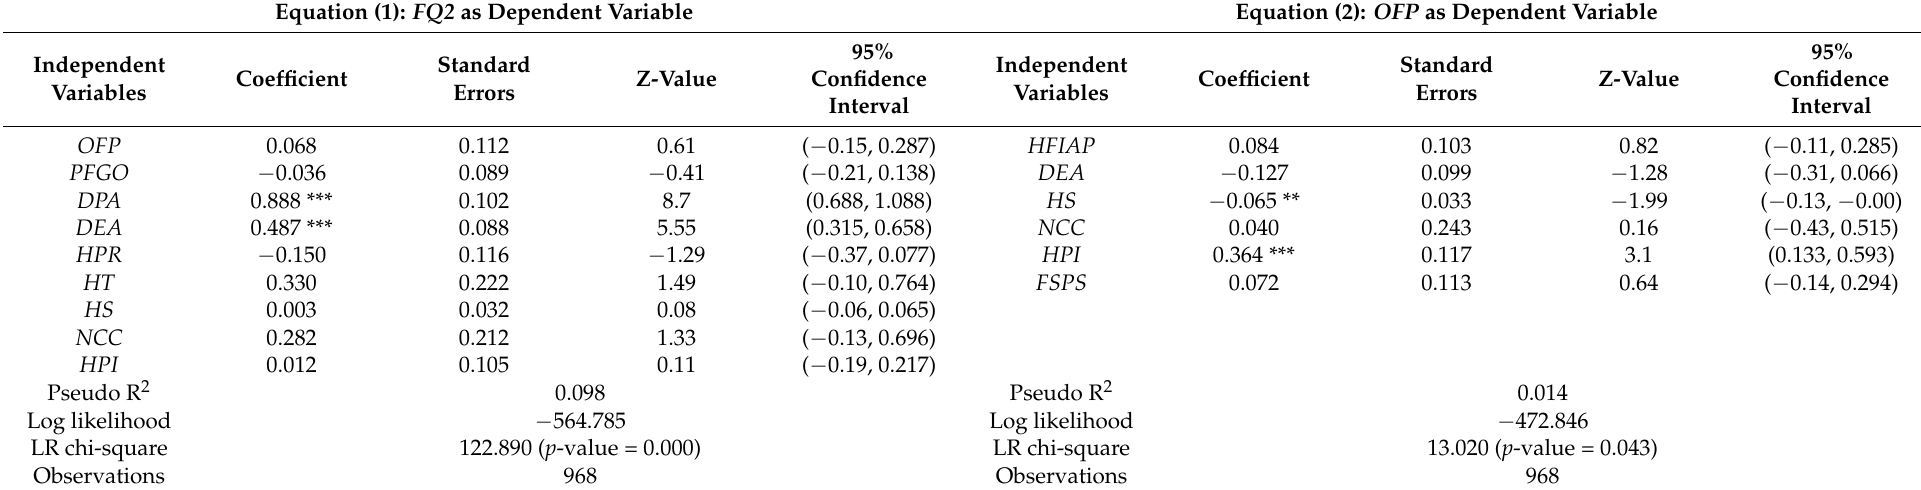
Table 8. Results of robustness tests of model